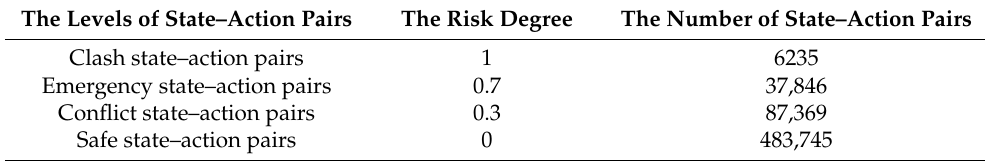
Table 10. The risk degree and the number of state–action pairs corresponding to different levels.